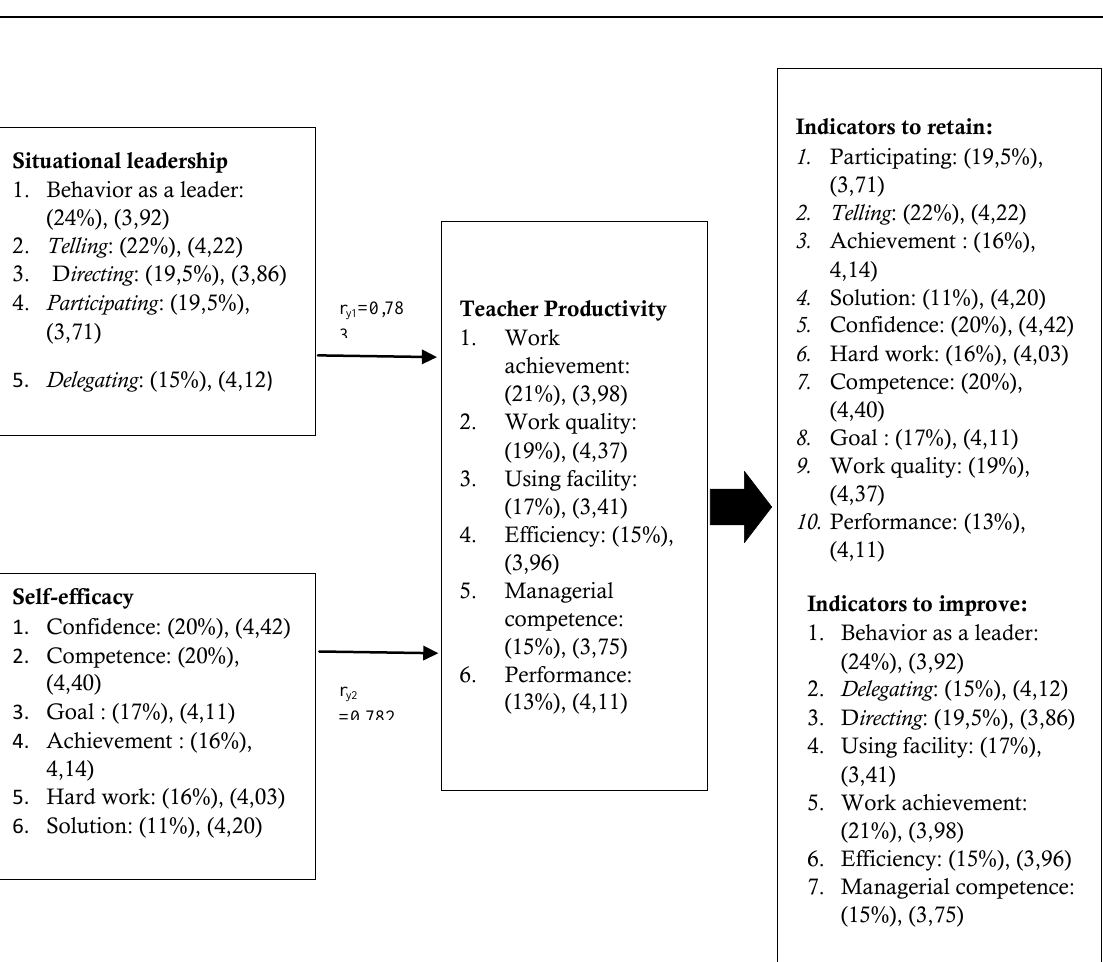
Figure 2. Indicators list to retain and improve based on